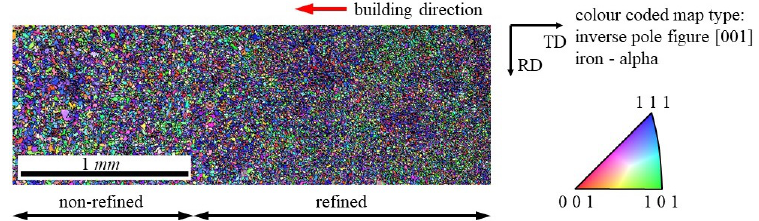
Figure 13. Crystal orientation map ([001] = ND, [010] = TD, [100] = RD) of WAAM-fabricated S355JR steel, according to the local coordinate system for the EBSD analysis; the colour coding implies that (cid:104) 111 (cid:105) / [ 001 ] is the dominating crystal direction; aspect ratio d min / d maj within the refined microstructure is between 0.51 ± 0.12 and 0.52 ± 0.11, long side is between d maj = 8 ± 2.8 µ m and d maj = 9.9 ± 3.6 µ m, the short side is between d min = 4.1 ± 1.3 µ m and d min = 4.8 ± 1.6 µ m; aspect ratio d min / d maj within the non-refined microstructure is 0.48 ± 0.13, long side is d maj = 13.3 ± 4.8 µ m, the short side is d min = 6.1 ± 2.1 µ m; calculation of Taylor factors based on at least 10,600 grains.